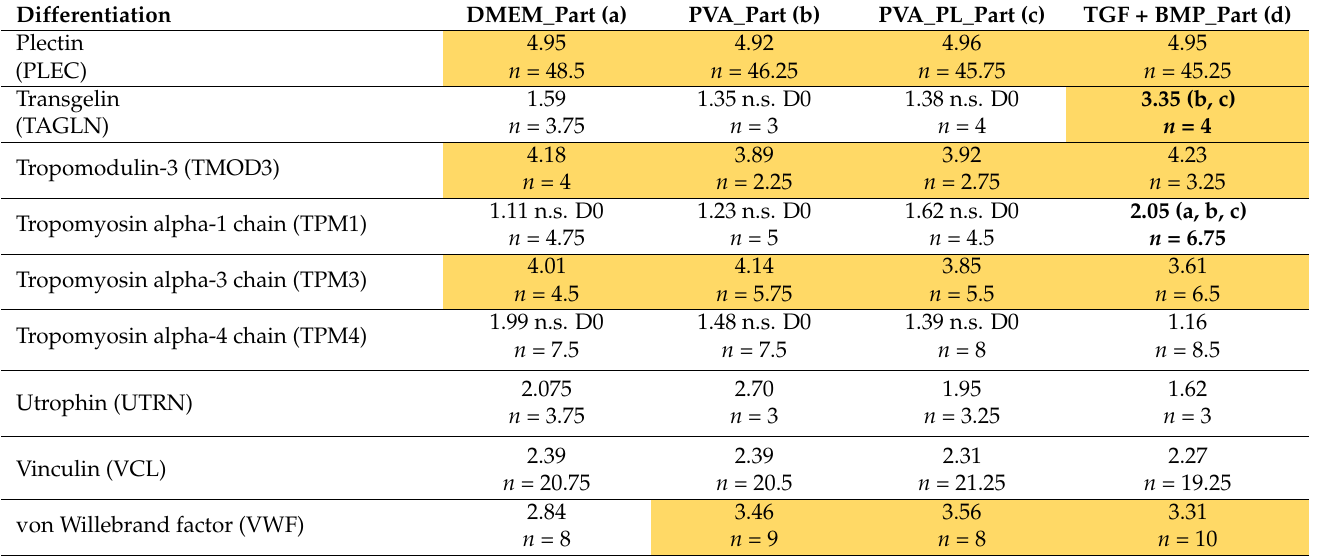
Table 3. Proteins of ECM produced by ASCs and ECs in DMEM_part, PVA_part, PVA_PL_part